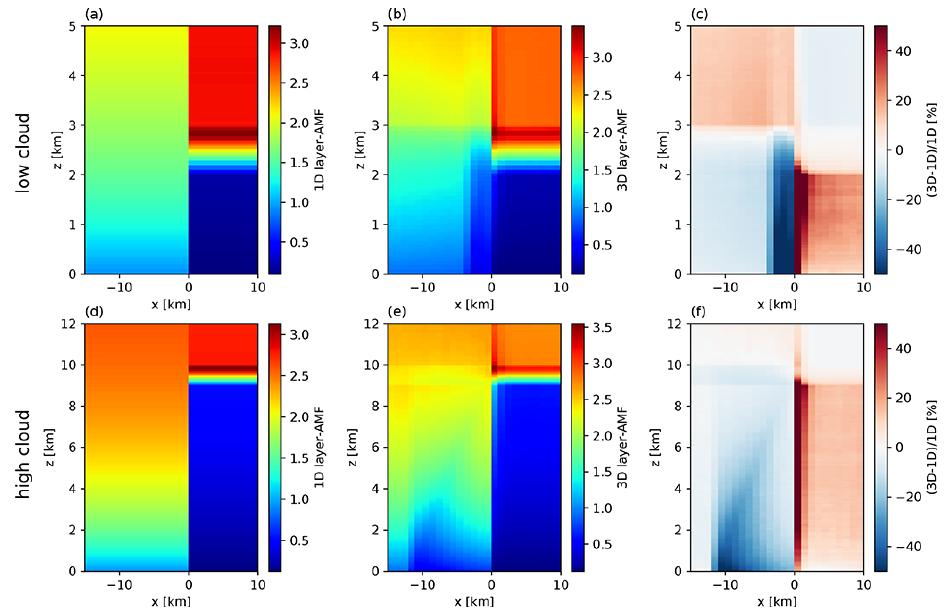
Figure 7. Layer air mass factors for the two base cases (SZA = 50 ◦ , surface albedo = 0 . 05) for cloud shadow geometry: layer-AMFs calcu- lated using 1D approximation (clear sky from x = − 15 to x = 0km and 1D cloud layer from x = 0 to x = 10km) for low cloud (a) and high cloud (d) , 3D simulation of layer-AMFs for low cloud (b) and high cloud (e) , and relative difference between 1D and 3D simulation for low cloud (c) and high cloud (f) . Note that the altitude range z in the upper panels (a – c) is from 0 to 5km and in the lower panels (d – f) from 0 to 12km.